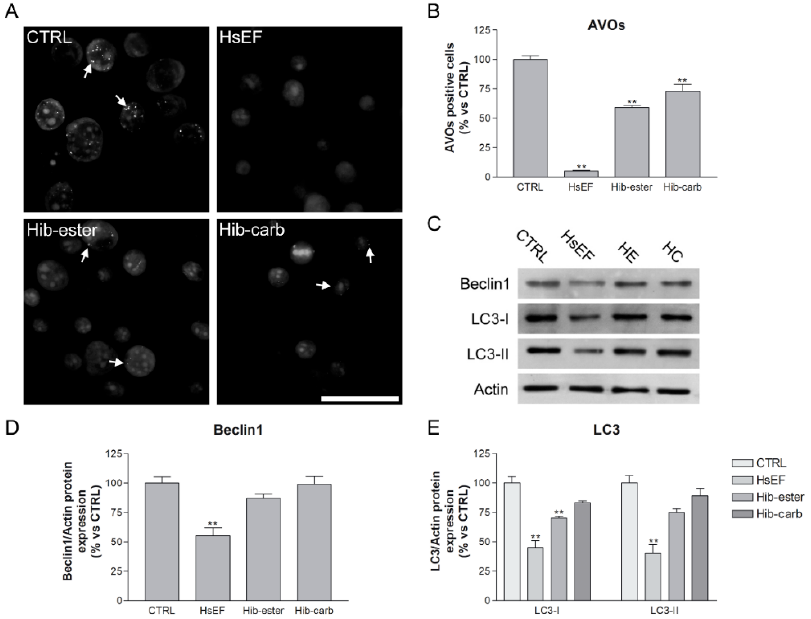
Figure 6. Autophagy inhibition ( A ) representative images of RPMI 8226 cells stained with Acridine Orange. Cells were not treated (CTRL) or treated with HsEF 3 mg/mL, Hib-ester 450 µ g/mL and Hib- carbaldehyde 200 µ g/mL for 24 h. ( B ) Red fluorescence of Acridine Orange images was quantified and data were represented in the graph as the percentage of AVOs positive cells compared to untreated controls (arbitrarily set to 100%). ( C ) Representative images of Western blots of Beclin1, LC3-I, LC3-II and actin. RPMI cells were not treated (CTRL) or treated with HsEF 3 mg/mL, Hib-ester 450 µ g/mL and Hib-carbaldehyde 200 µ g/mL for 24 h. ( D , E ) Quantification of Western blots of Beclin1, LC3-I and LC3-II. Data are expressed as mean percentage ± SD compared to untreated controls, arbitrarily set to 100%. (** p < 0.01 vs.